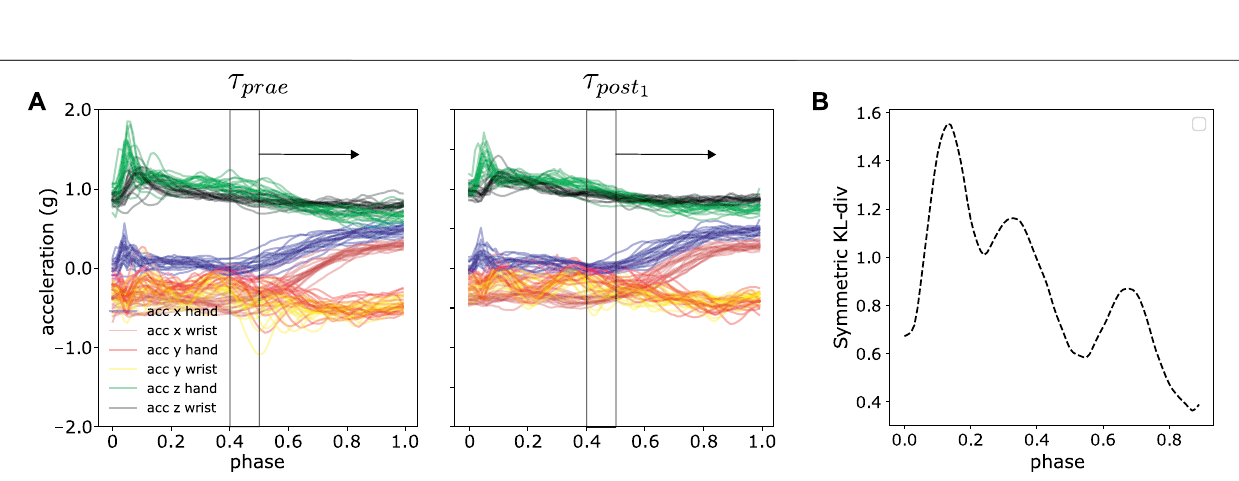
FIGURE 9 | An illustration of ProMPs with D KLS detecting data outliers. (A) High D KLS case in participant 19, tDCS, the sixth experiment, brown bar shows remarkably higher value than others, indicating a potential outlier. (B) Post-processed data for the experiment 6 in tDCS. The yellow curve accounts dominantly for the high divergence, interpreted as a different motion behavior in Prae from other three.